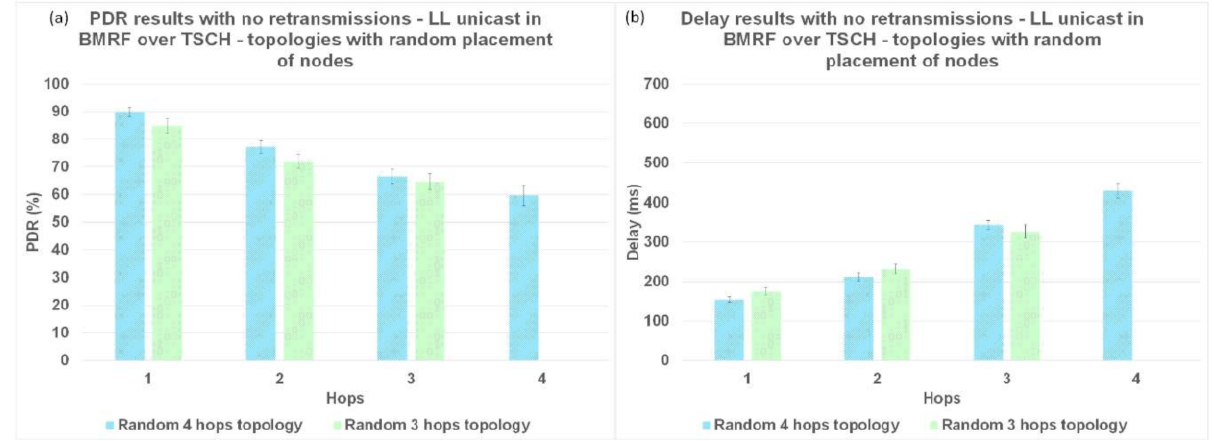
Figure 14. Retransmission influence on LL unicast ( a ) PDR results for LL unicast in BMRF over TSCH without retransmis- sions. ( b ) Delay results for LL unicast in BMRF over TSCH without retransmissions.